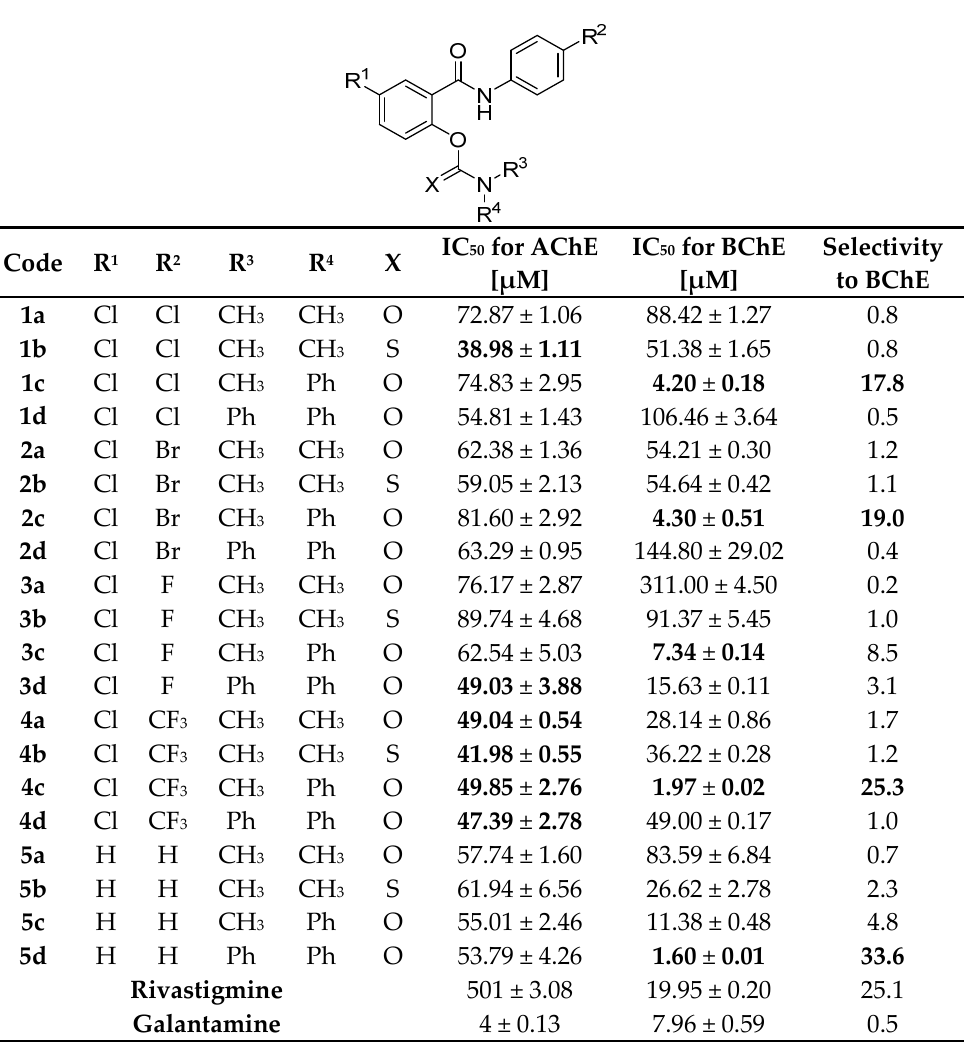
Table 1. IC 50 values for acetylcholinesterase and